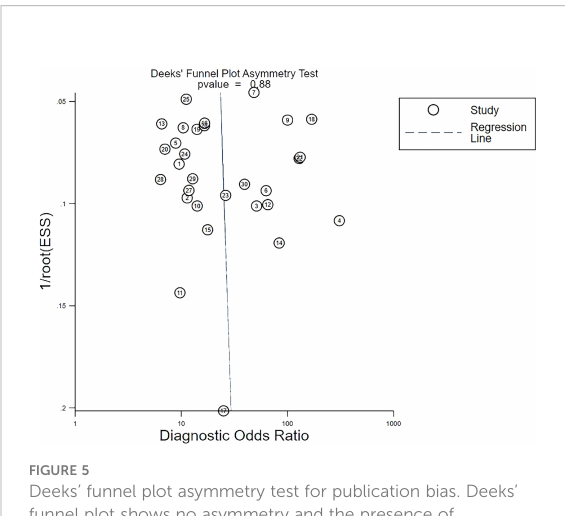
FIGURE 5 Deeks ’ funnel plot asymmetry test for publication bias. Deeks ’ funnel plot shows no asymmetry and the presence of publication bias. Each circle indicates one included study. ESS, effective sample size.